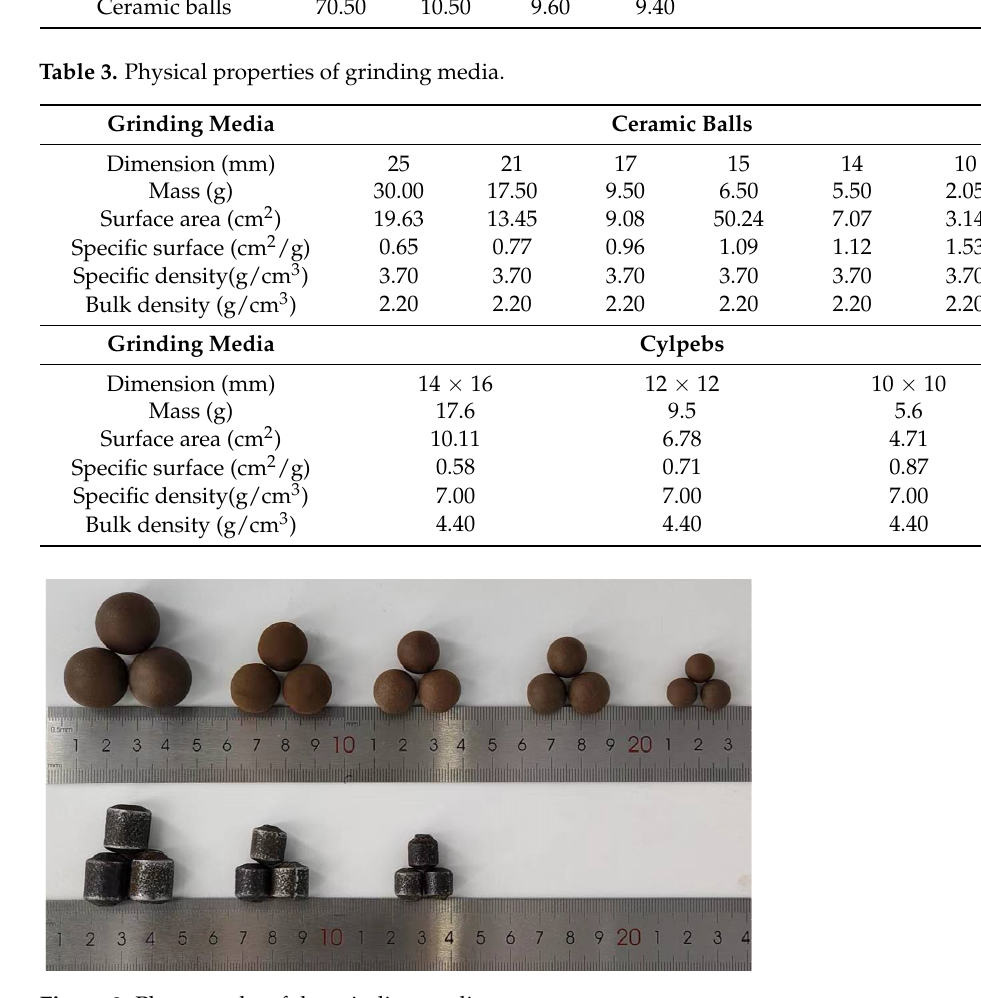
Table 3. Physical properties of grinding media.